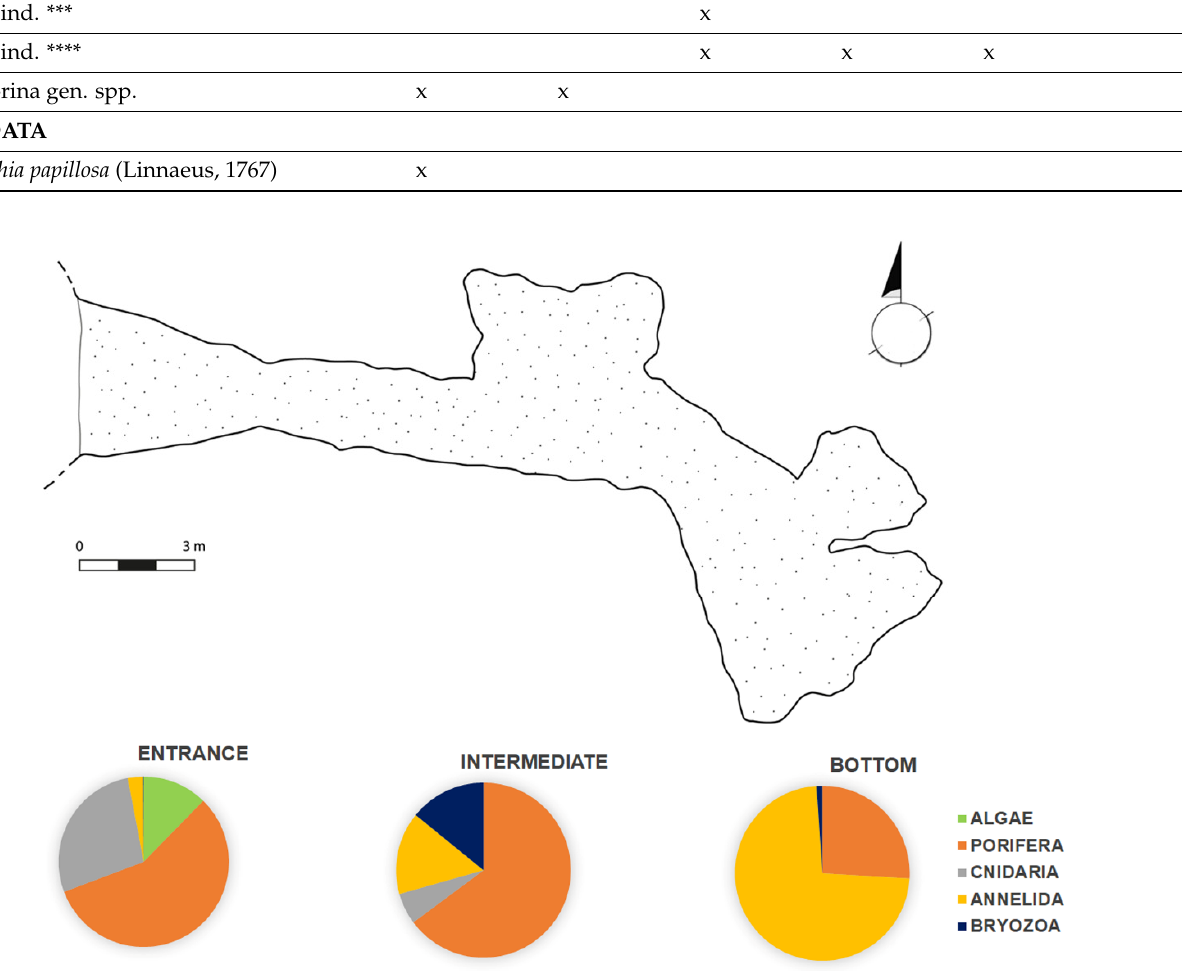
Figure 4. Percent cover of the benthic organisms in the three sectors of the Elle cave: Entrance, intermediate, and bottom sector.